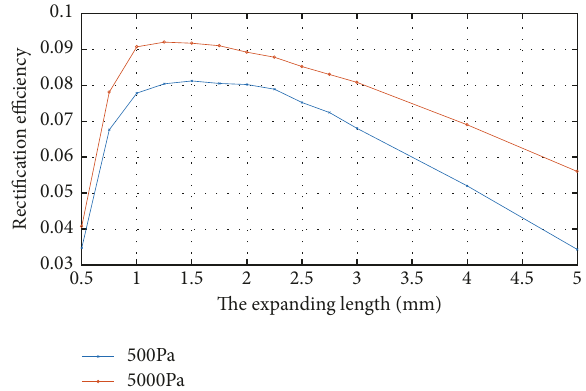
Figure 11: Relationship between the expanding length and the rectification